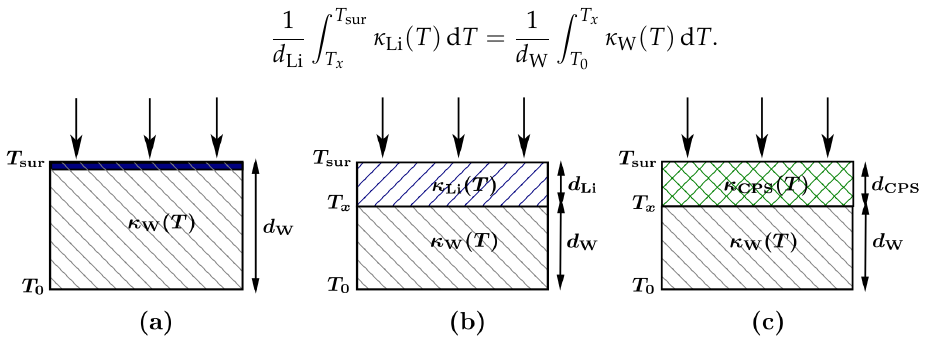
Figure 1. Schematic drawing of the three target substrate models: model of one layer ( a ), two layers ( b ), and CPS layer ( c